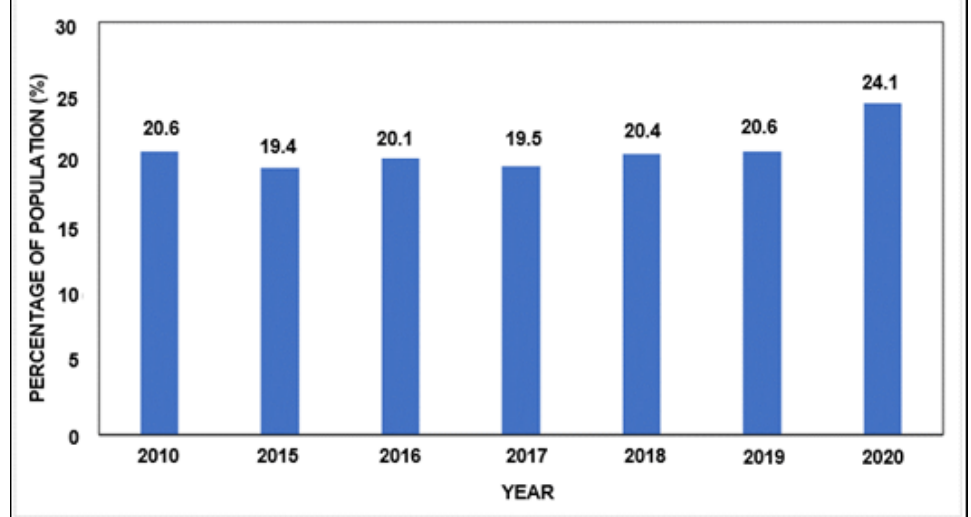
Figure 2. Prevalence of undernourishment in SSA between 2010 and 2020 (Source: FAO